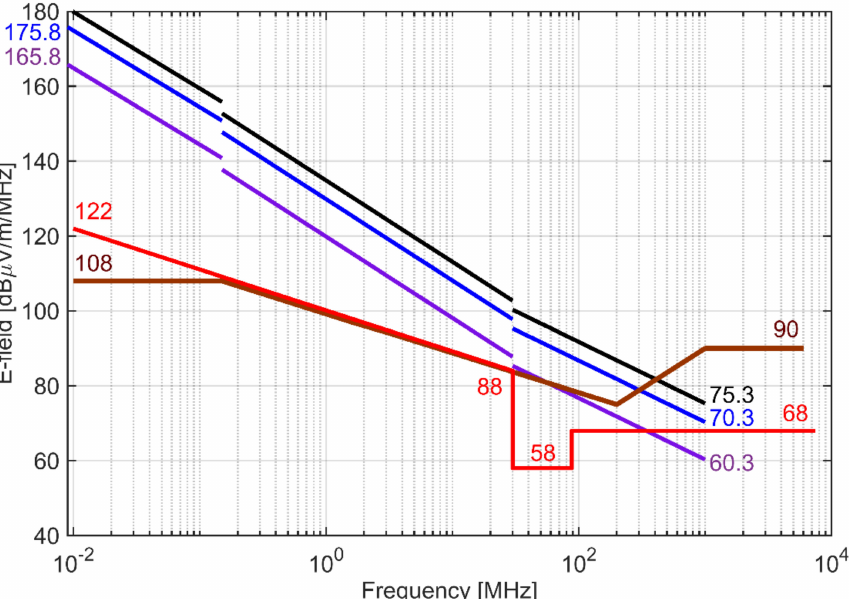
Figure 1. Limits as E-field per MHz at distance of 100 ft (far field calculation from H-field by applying the +51.5 dB correction; linear with respect to Resolution Bandwidth (RBW)): EN 50121-3-1 dynamic Peak limits for railways (black), metros (blue), trams (violet); New York R211 (red); Los Angeles HR4000